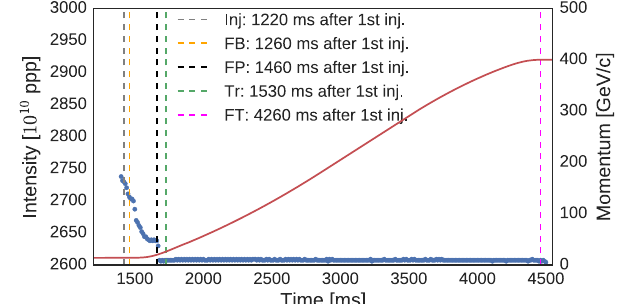
FIG. 14. Example of beam intensity in the SPS as a function of